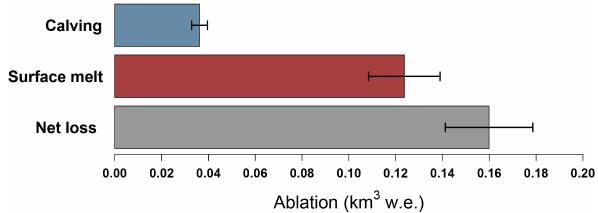
Figure 10. Ablation due to calving and surface melt (below the ELA) at Bridge Glacier during the 2013 melt